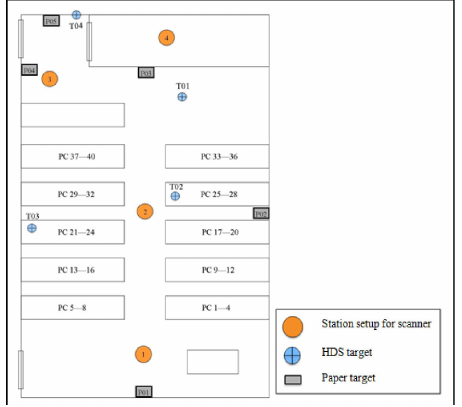
Figure 5. The distribution of scan stations and